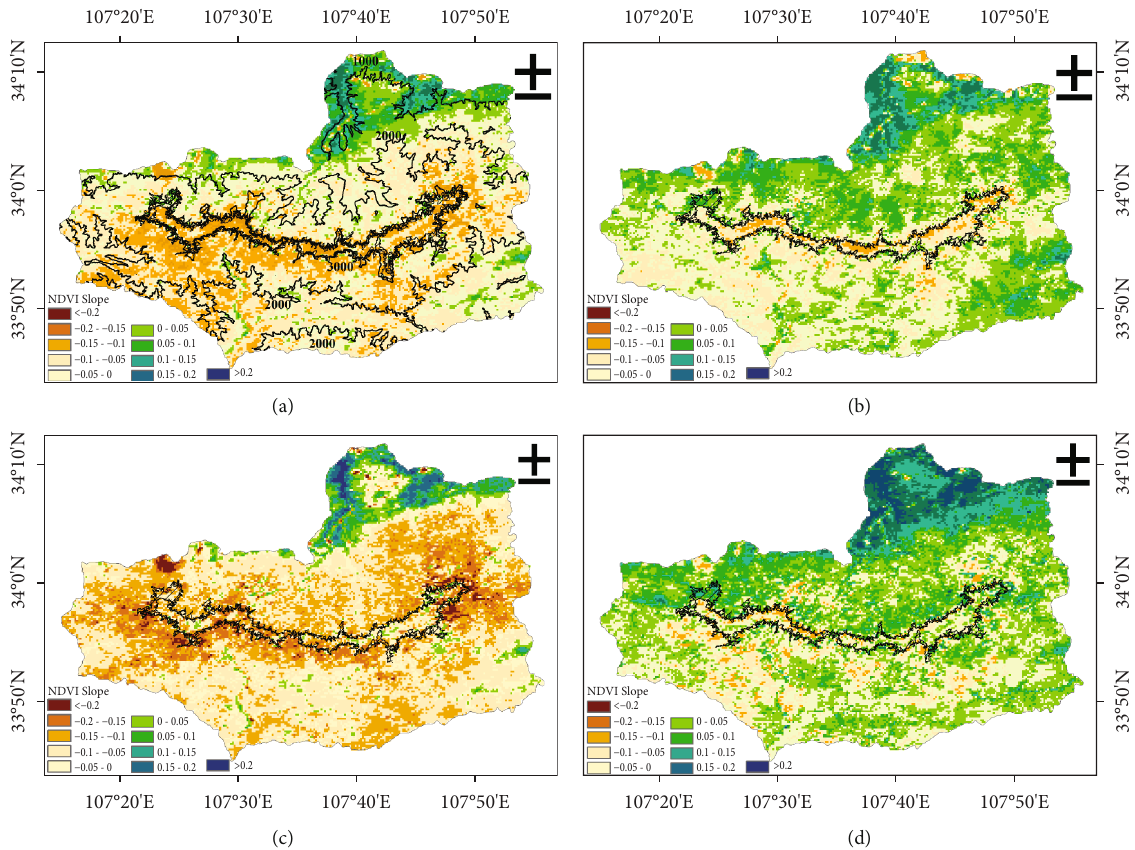
Figure 6: Spatial patterns of trends in the annual and seasonal NDVI slope of Taibai Mountain from 2000 to 2020: (a) growing season, (b) spring, (c) summer, and (d)